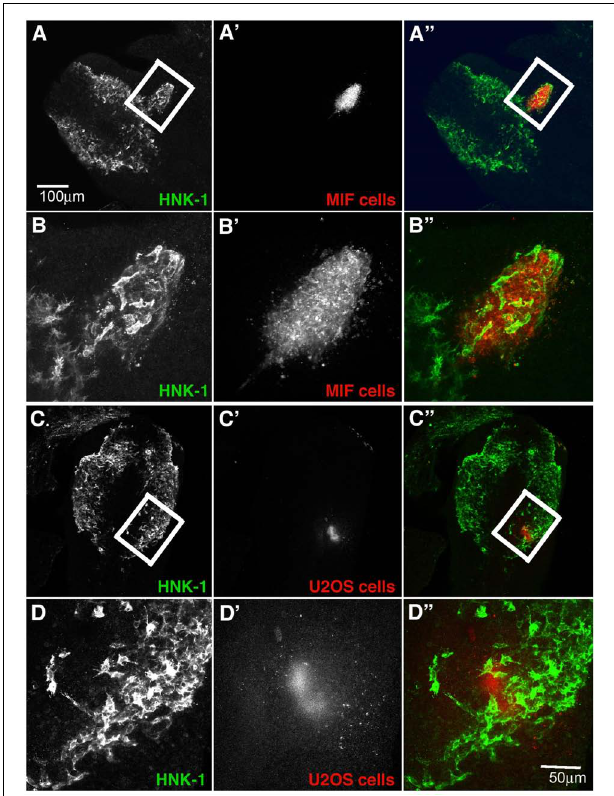
FIGURE 9 | Exogenous MIF attracts tNCC in vivo . (A,A’,A”) Shows HNK1 (green) and, DiI U205 MIF-expressing cells (red), in the head of a HH10 embryo. (B,B’,B”) A higher magnification image taken from a confocal stack of the boxed area in (A) . Injected cells (red) were enveloped by HNK1 + NCC (green). (C,C’,C”) Shows HNK1 (green) and, DiI MIF cells (red), in the head of a HH10 embryo. (D,D’,D”) Is a higher magnification image taken from a confocal stack of the boxed area in (C) . Injected cells (red) NCC were not associated with the control cell clump (U205). Scale Bars are for